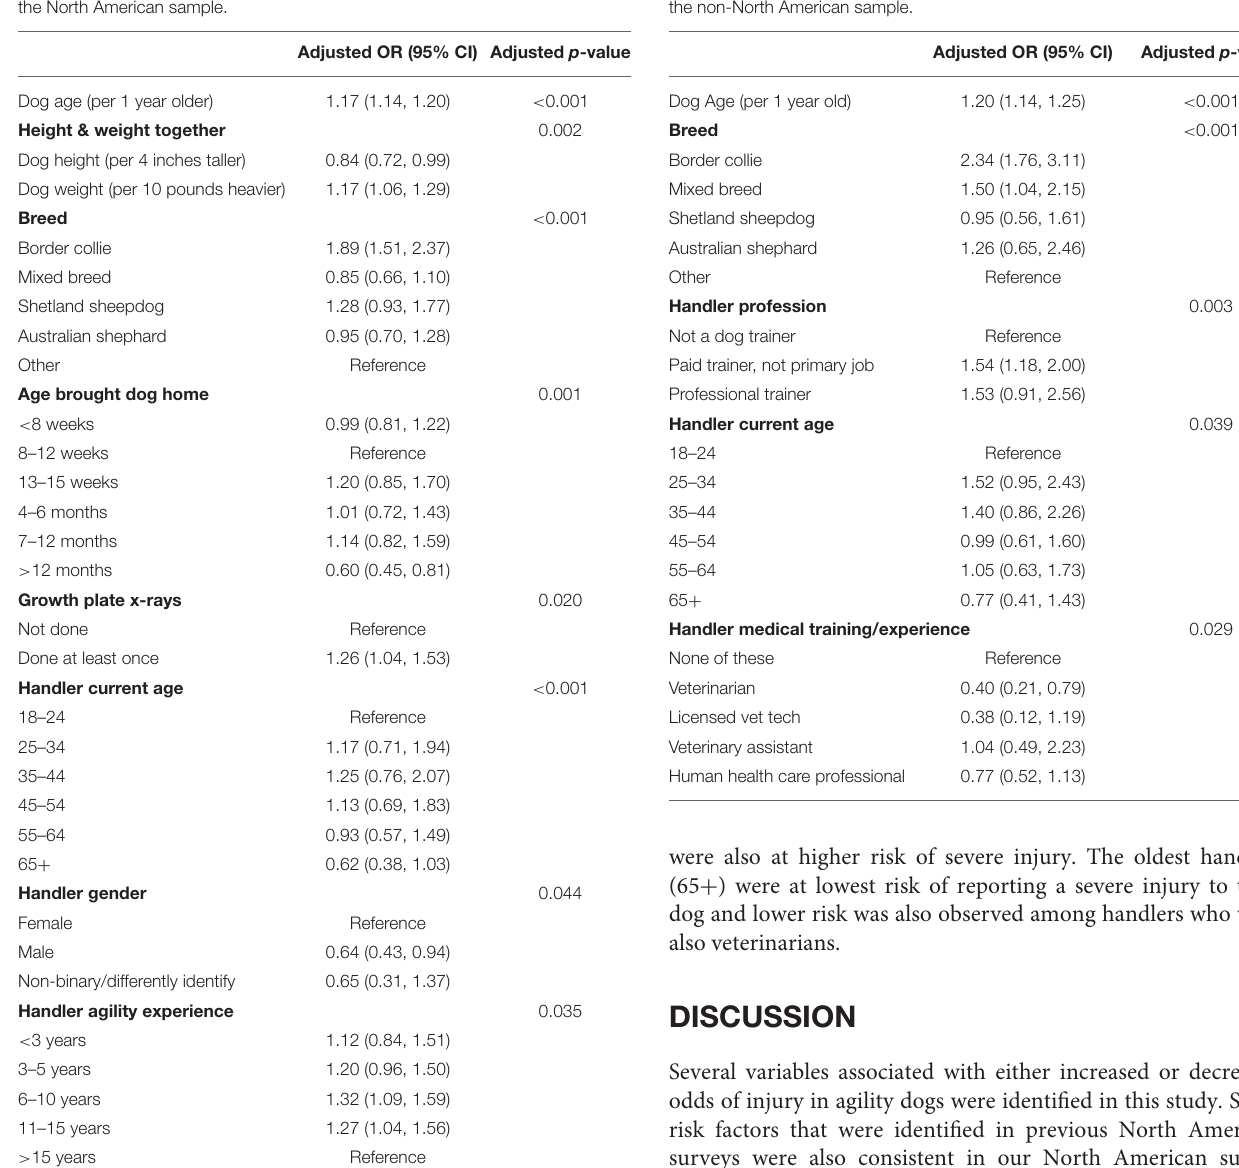
TABLE 4 | Coefficients from final adjusted model of risk factors of any injury using the non-North American